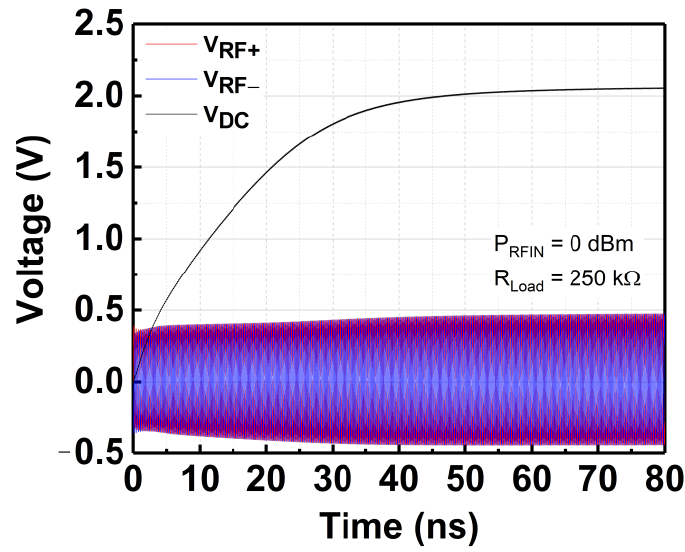
Figure 7. Rectification response of the 3-stage CCDD rectifier at 3GHz.